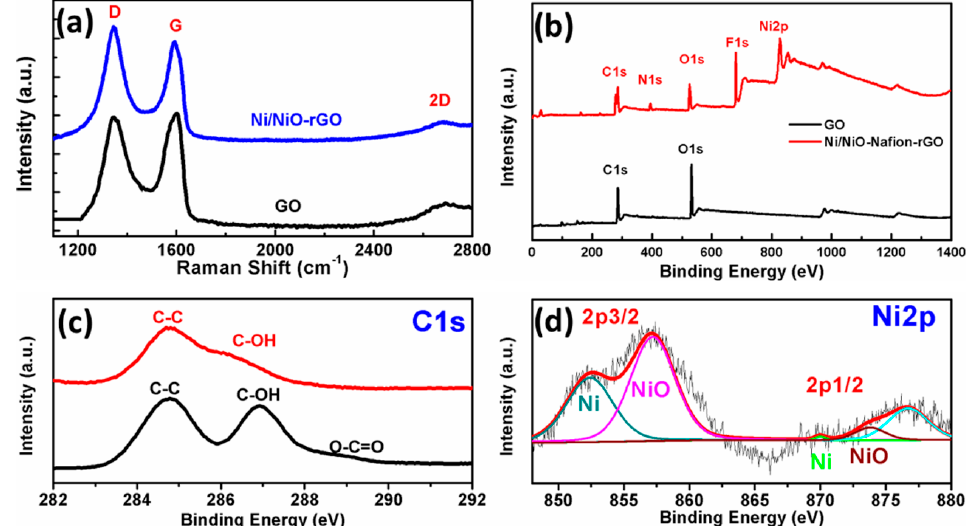
Figure 2. Structure characterization of the in-situ reduction of Ni/NiO-rGO nanocomposite: ( a ) Raman spectra of GO (black curve) and Ni/NiO-rGO nanocomposite (blue curve); ( b ) Entire XPS spectra of GO (black curve) and Ni/NiO-Nafion-rGO nanocomposite (red curve); ( c ) XPS spectra of C1s for GO and Ni/NiO-Nafion-rGO; and ( d ) XPS spectrum of Ni2p for Ni/NiO-Nafion-rGO.